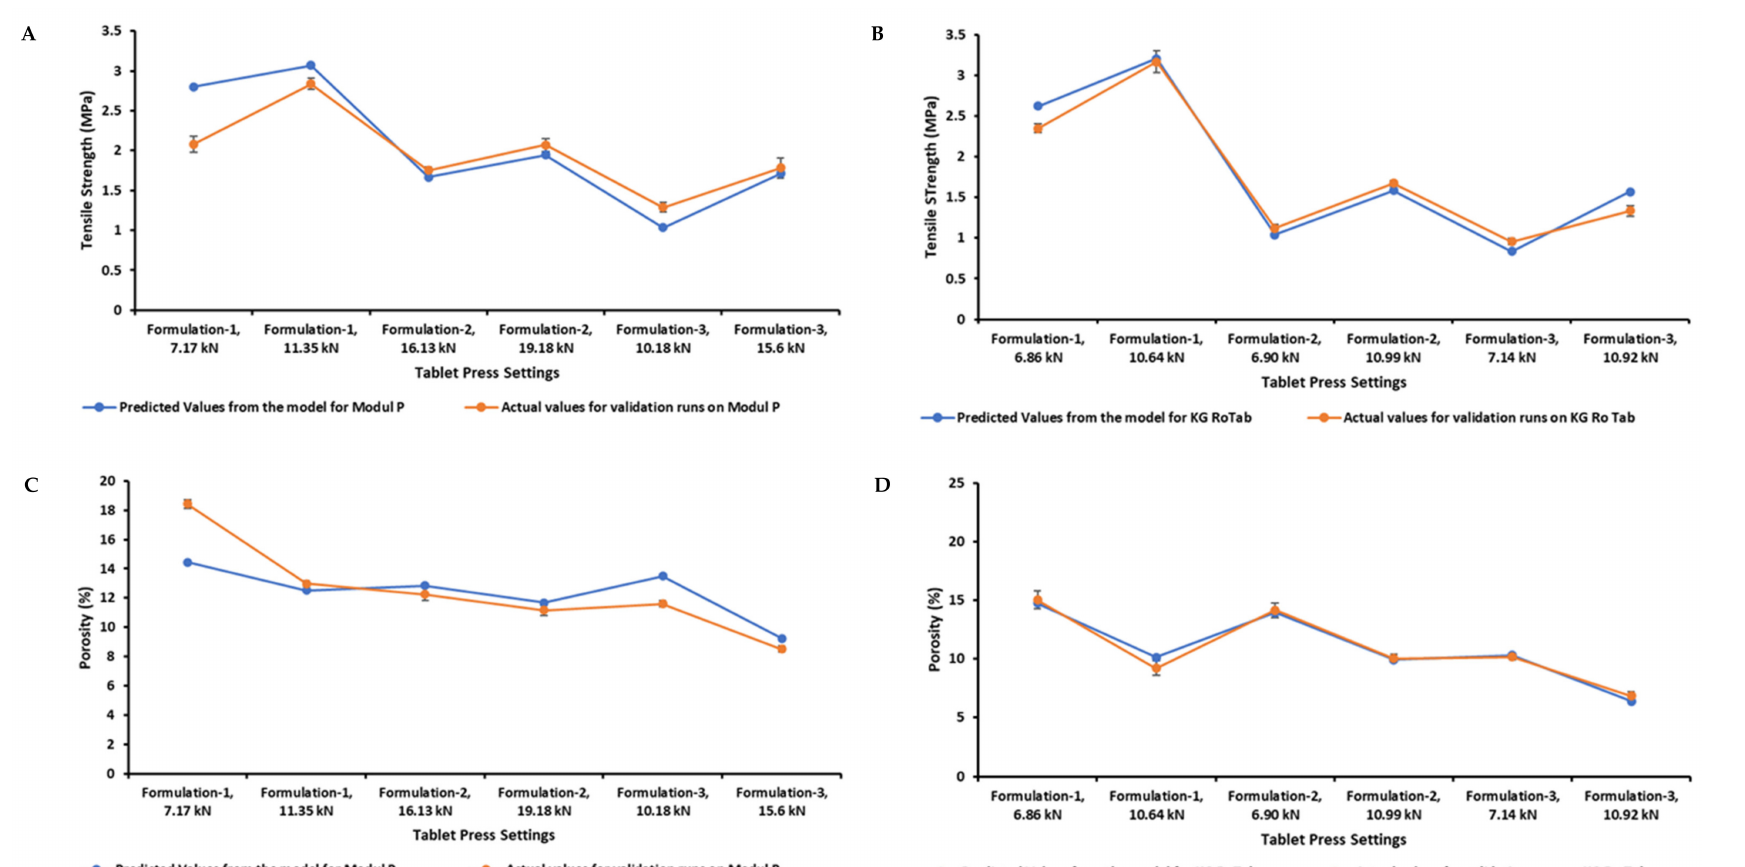
Figure 6. Validation of formulations 1–3 on a production-scale tablet press (Modul P) ( A , C ) and a pilot-scale one (KG RoTab) ( B , D ). The models were validated at a press speed of 14,400 TPH on KG RoTab and 50,000 TPH on Modul P at two different compression forces for each formulation. Actual values of tensile strength and porosity from the runs for the formulations on two presses were taken and compared to the values predicted using model at similar settings. For actual values, average values are shown, n = 10 and the y error bar indicates standard